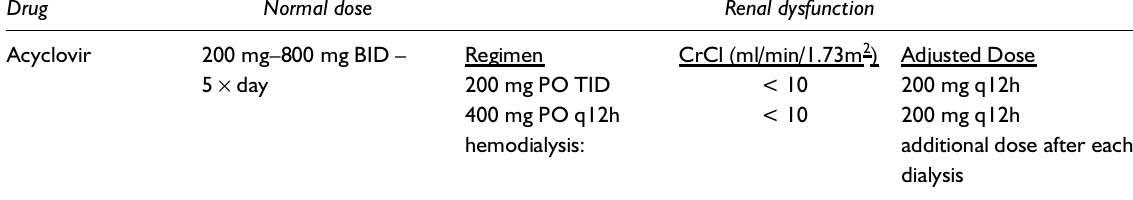
Table 8 Dosing of drugs for primary prevention or maintenance therapy for opportunistic infections in renal